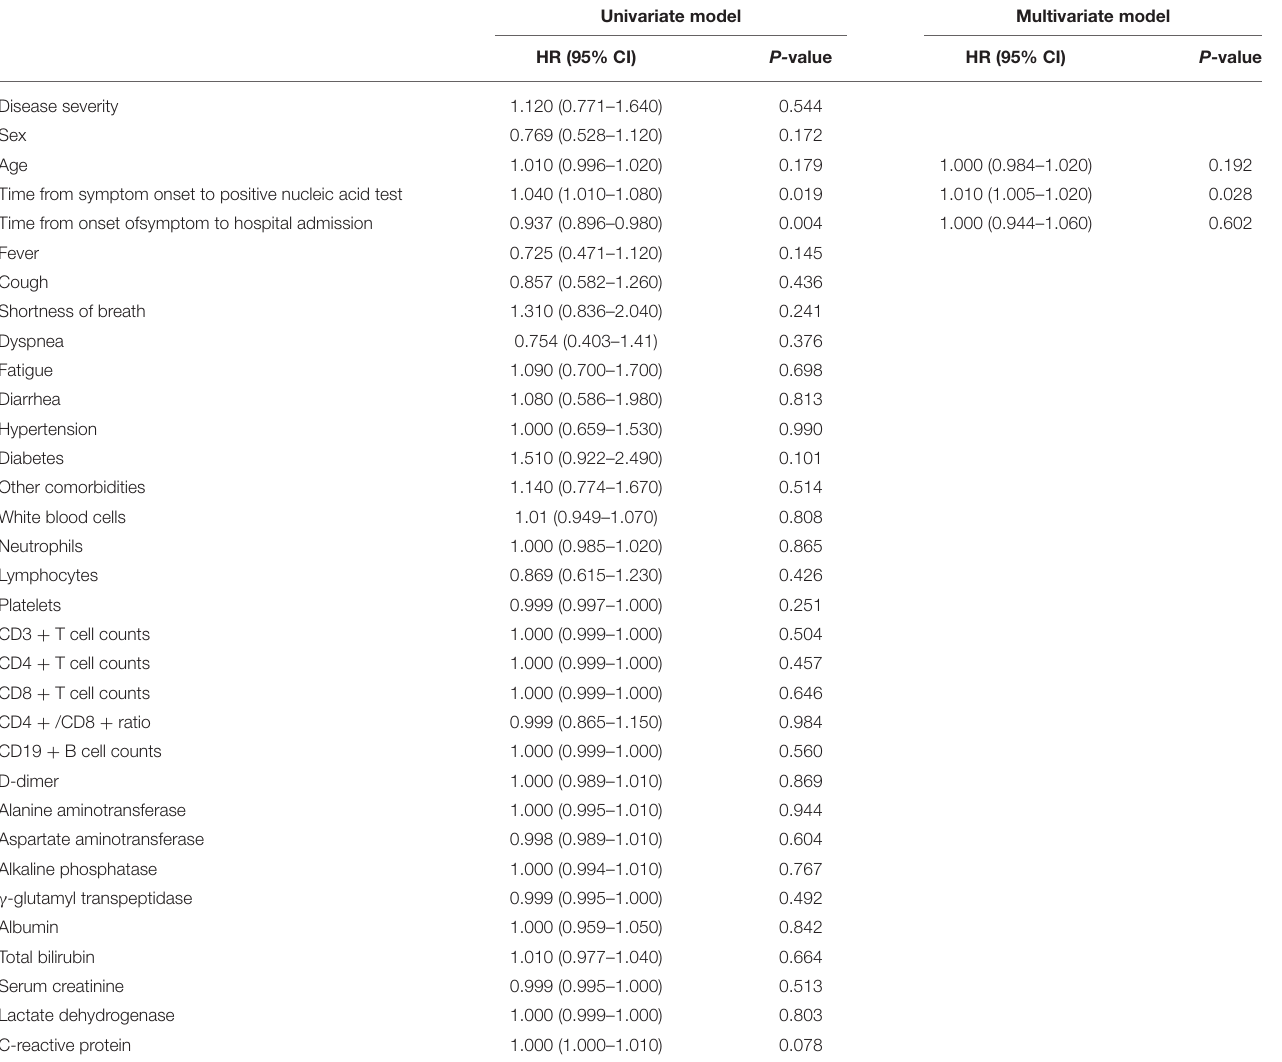
TABLE 4 | Univariate and multivariate cox regression model analysis results of the conversion time from positive to negative nucleic acid